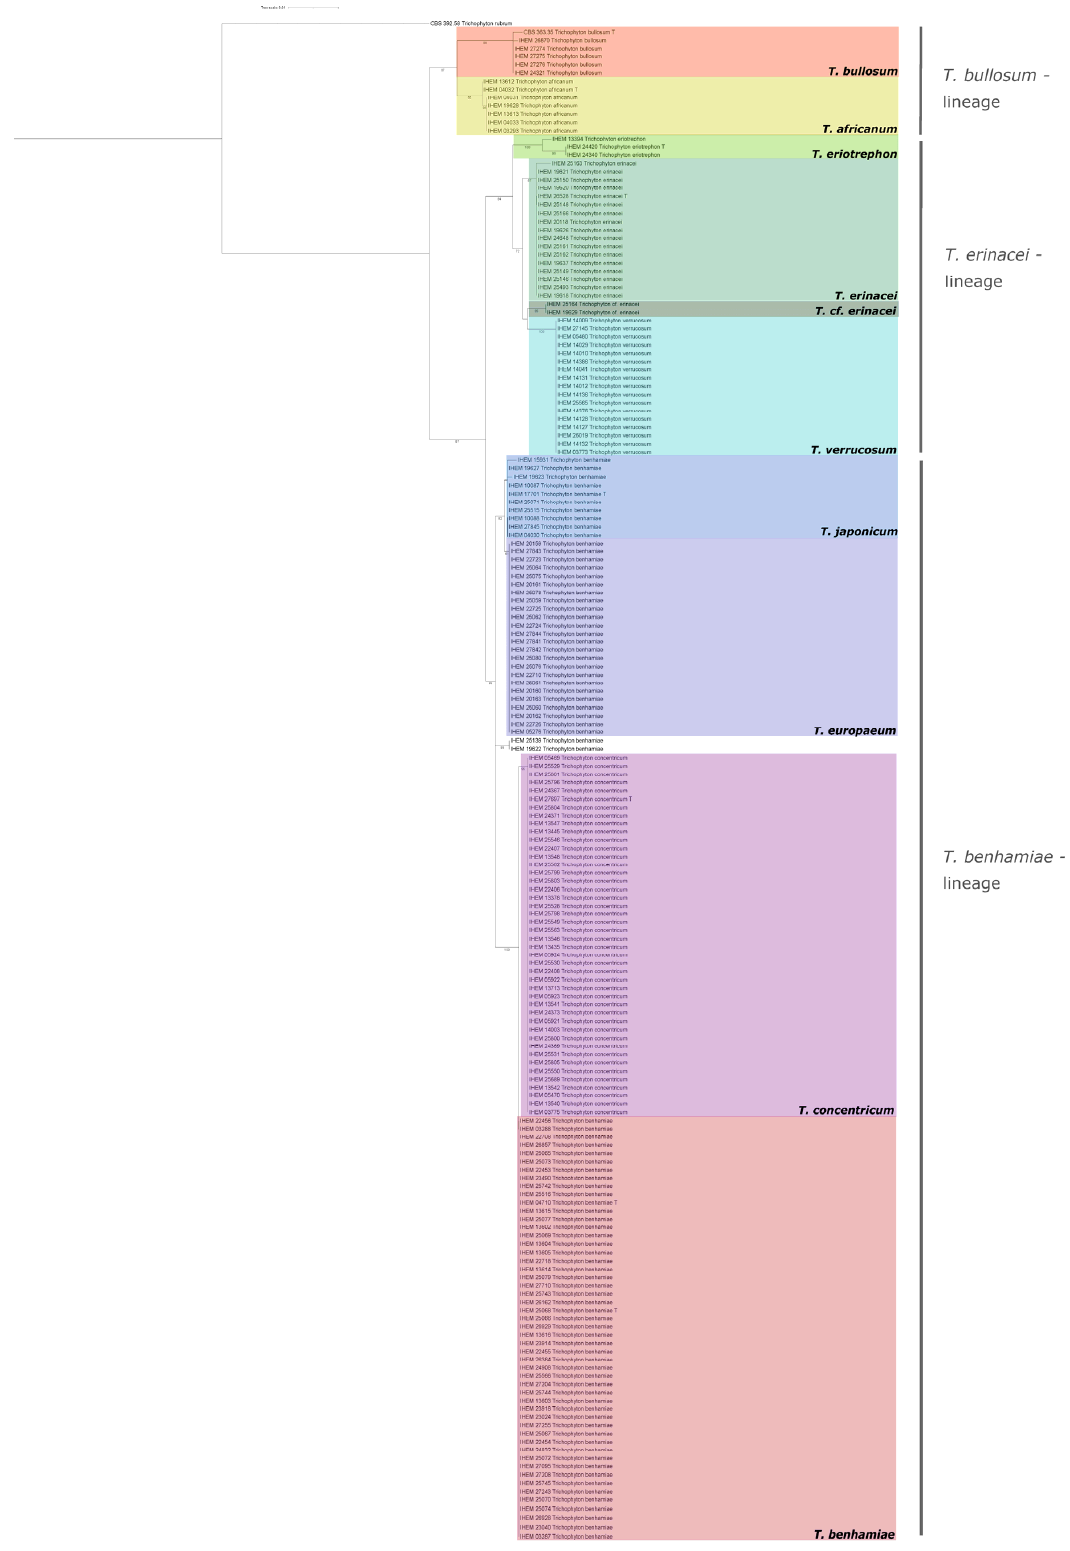
Figure 1. Maximum likelihood phylogenetic tree of the Trichophyton benhamiae complex based on internal transcribed spacer (ITS) and beta-tubulin (BT), with the type strain of Trichophyton rubrum (CBS 392.58) as the outgroup. Tree inferred via maximum likelihood method using IQ-TREE software. Bootstrap values are provided at the nodes based on 1000 bootstrap replicates, only values higher than 70% are displayed. Trichophyton rubrum CBS 392.58 was used as outgroup, type strains are indicated with